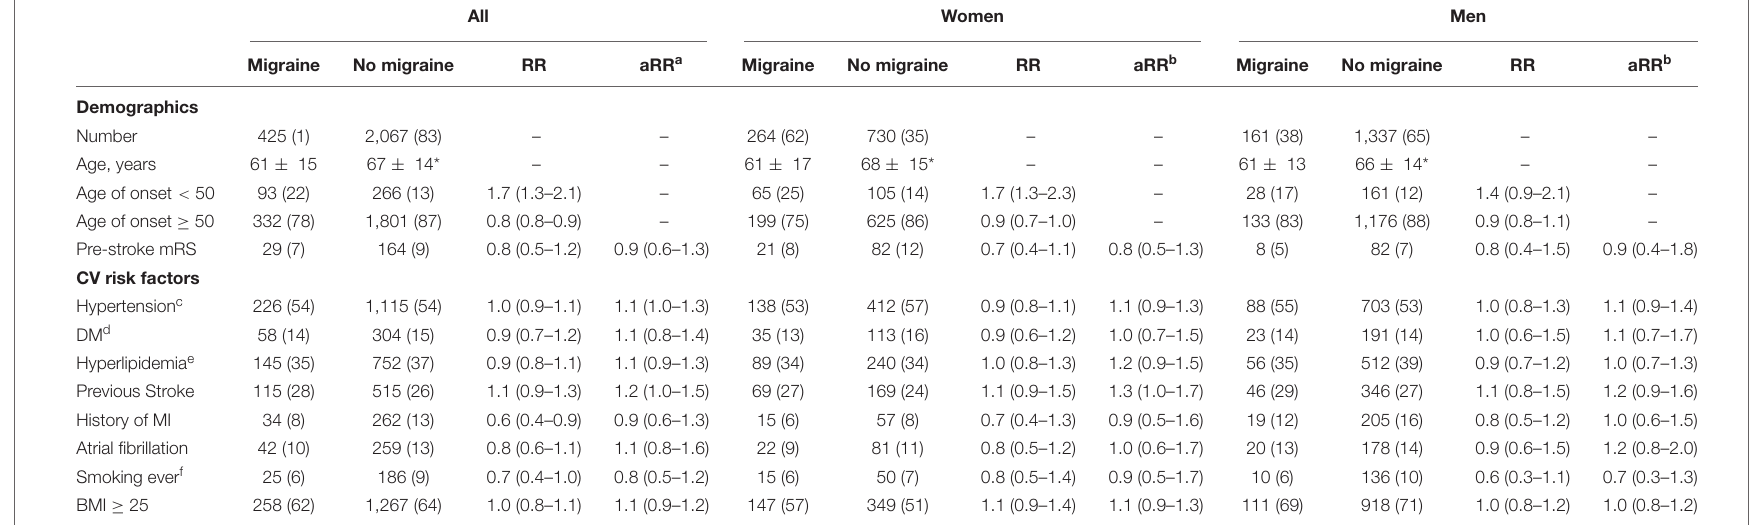
TABLE 1 | Demographics and cardiovascular risk factors.